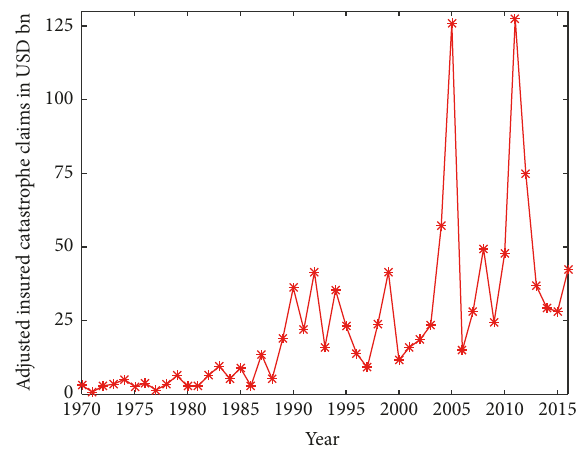
Figure 3: Adjusted global insured claims from natural catastrophes during 1970–2016 (USD billion, 2016 prices).